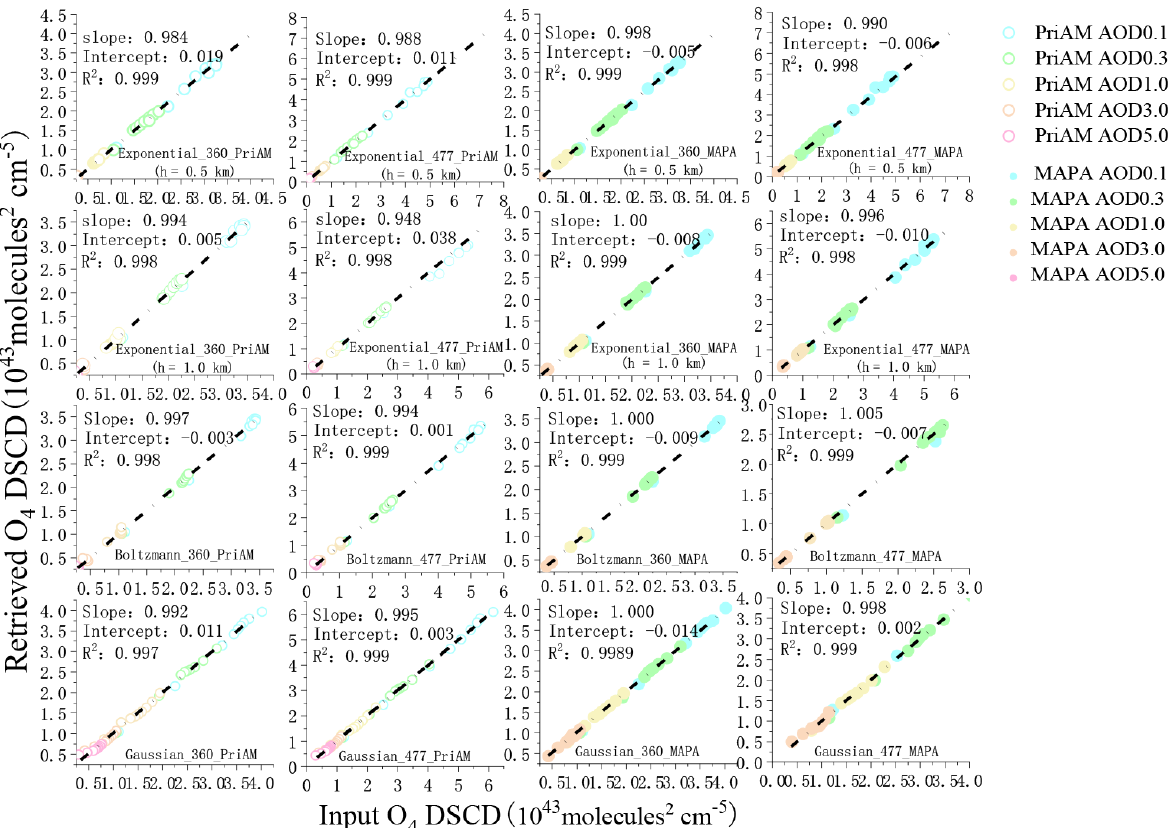
Figure 7. Correlation plots between the retrieved O 4 DSCDs and the input O 4 DSCDs for PriAM and MAPA The open and closed circles denote the retrieved O 4 DSCDs from PriAM and MAPA, respectively. The colors refer to the AOD shown on the top right.